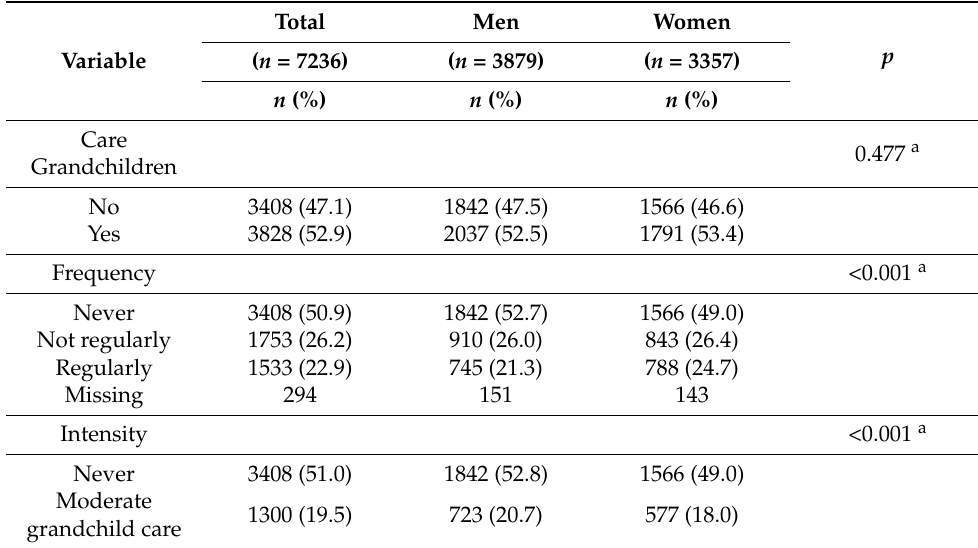
Table 4. Patterns of grandparent caregiving in male vs. female